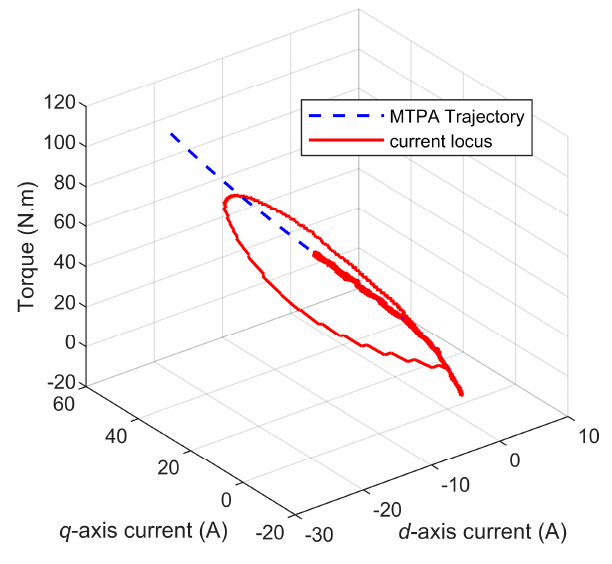
Figure 4. The transient current locus and the desired MTPA trajectory.